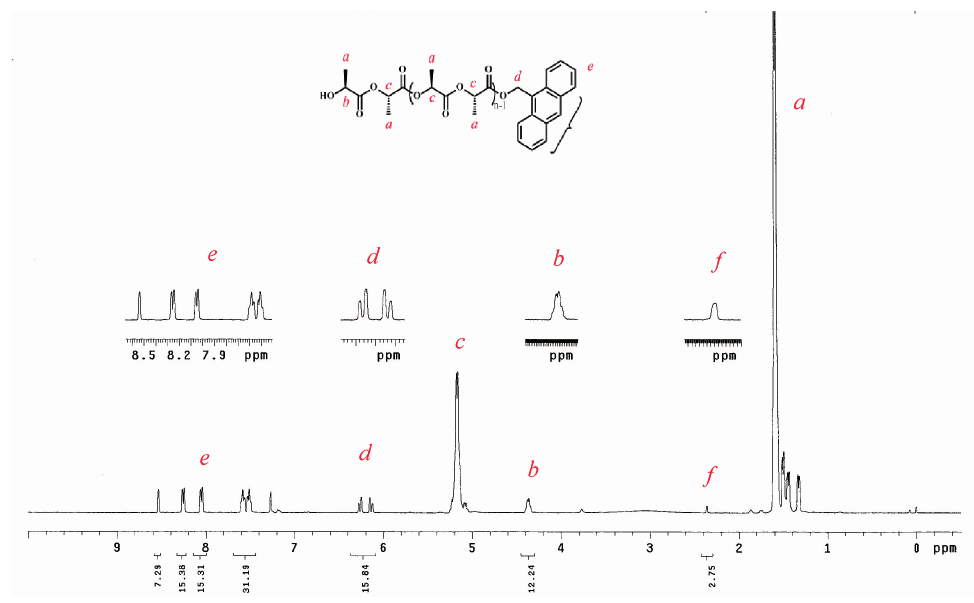
Figure 5. 1 H-NMR spectrum of PLLA-50 catalyzed by 3 in the presence of 9-AnOH in toluene.